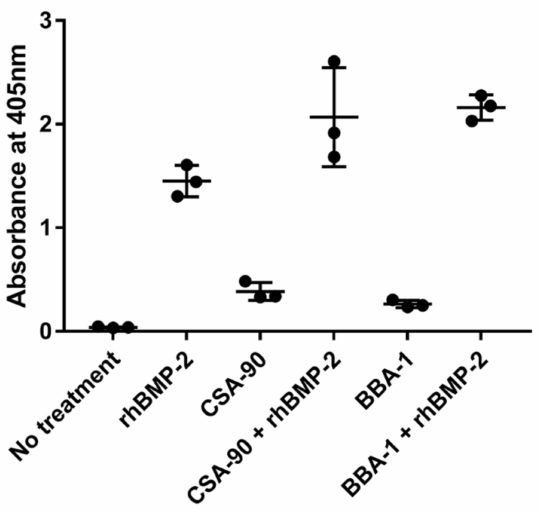
Figure 8. Quantitative spectroscopic alkaline phosphatase assay. BBA-1 showed a similar effect on alkaline phosphatase activity alone and in combination with rhBMP-2 as CSA-90 in MC3T3-E1 pre-osteoblast cells.